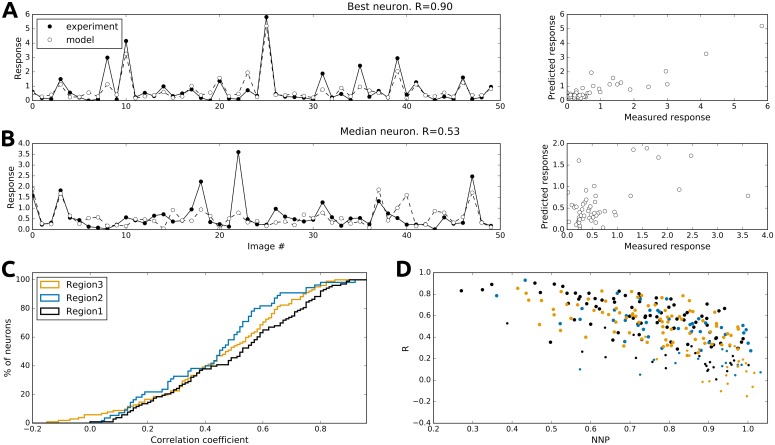
Responses predicted from the HSM are highly correlated with recorded neuronal responses.The measured mean activity (full circles) and the predicted responses (empty circles) for a neuron with highest correlation (R = 0.90, P<0.001)(A) and a neuron with median correlation (R = 0.53, P<0.001)(B). (C) The cumulative distribution functions of correlation coefficients across the population of 260 neurons in the three measured regions. (D) Normalized noise power [28] and the performance of the model are negatively correlated (R = -0.63, -0.55 and -0.67 for the three regions, P<0.001 for all regions). Higher normalized noise power implies lower and more variable prediction performance. The small dots indicate neurons for which the model performance (correlation between predicted and recorded responses) was not statistically significant (based on bootstrapped 95% confidence intervals).